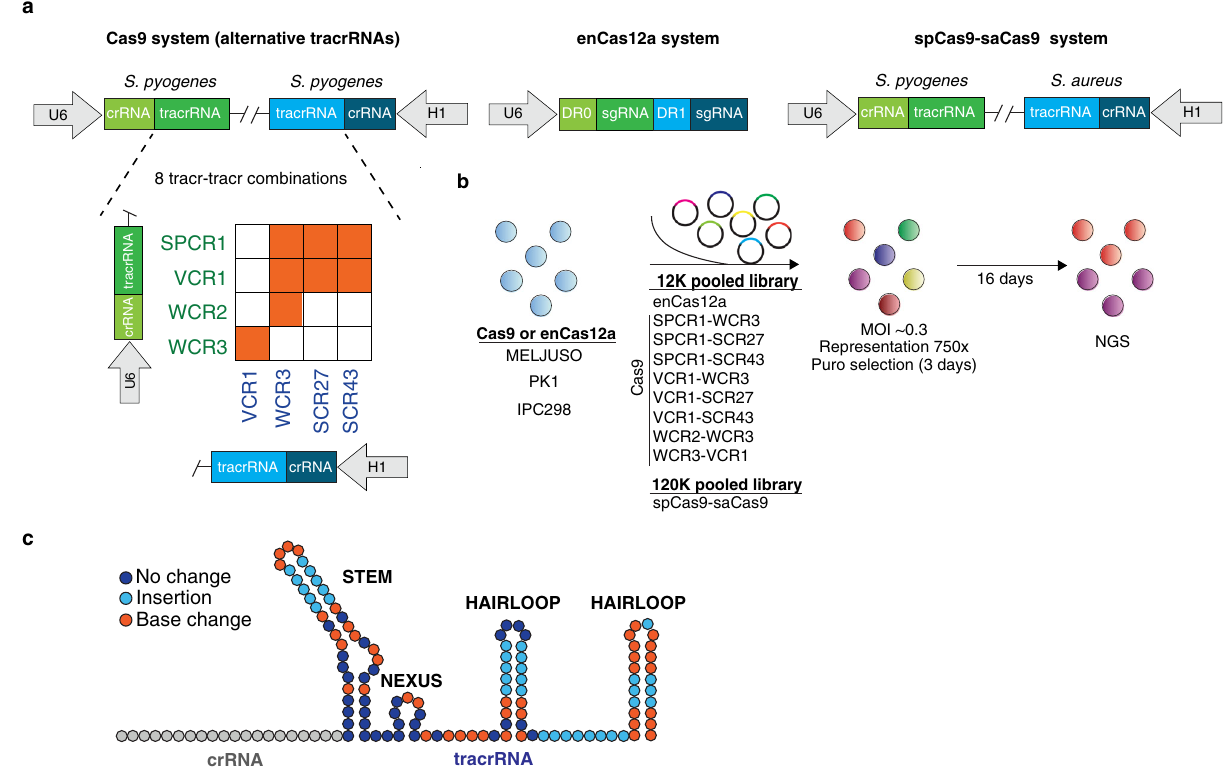
Fig. 1 Comparison of combinatorial CRISPR libraries. a Three main combinatorial CRISPR systems evaluated: eight distinct combinations of alternative spCas9 tracrRNAs sequences (orange boxes represent libraries generated), enCas12a, and orthologous spCas9-saCas9 system. b Schematic representation of the CRISPR screen pipeline. Ten distinct libraries are screened in IPC298. spCas9 - saCas9, enCas12a, VCR1-WCR3, and WCR2-WCR3 libraries are screened in PK1 and MELJUSO. c Schematic of sgRNA constant regions with indicated alterations compared to original spCas9 tracrRNA. Dark blue represents canonical sequence; light blue represents regions where insertions are introduced; orange represents base